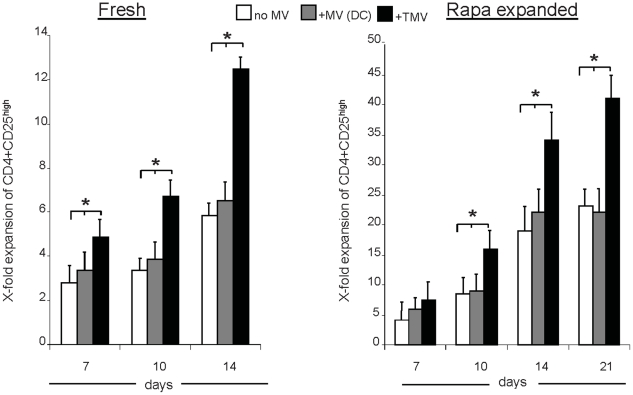
TMV promote expansion of human Treg in culture.The fold expansion of fresh (left panel) or rapamycin-expanded (right panel) CD4+CD25high T cells to which TMV or DC-derived MV were added on day 0. Cells were stimulated with OKT3, anti-CD28 Abs and IL-2 (500 IU/mL) and cultured for 14–21 d. The data are means ± SD of six independent co-cultures. Asterisks indicate significant differences (p<0.05) between the cultures ± TMV.